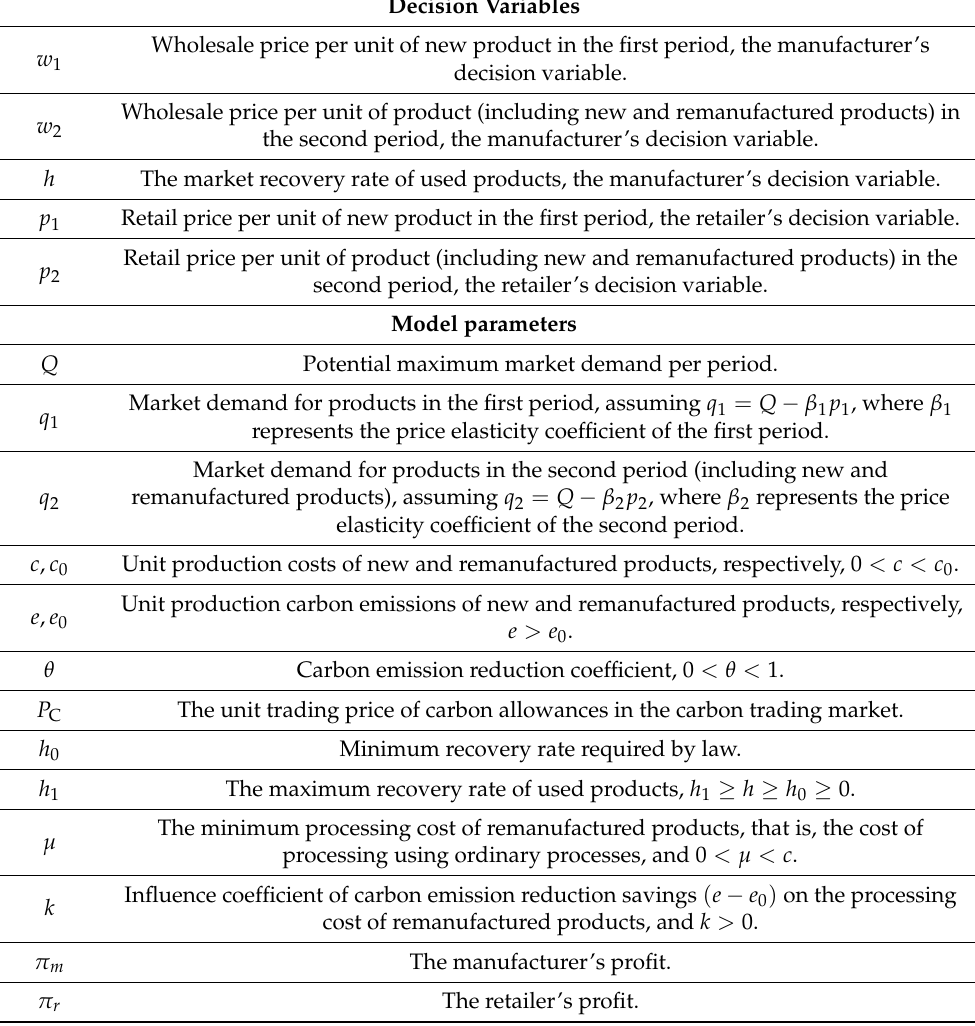
Table 2. Variables and parameters involved in the model.